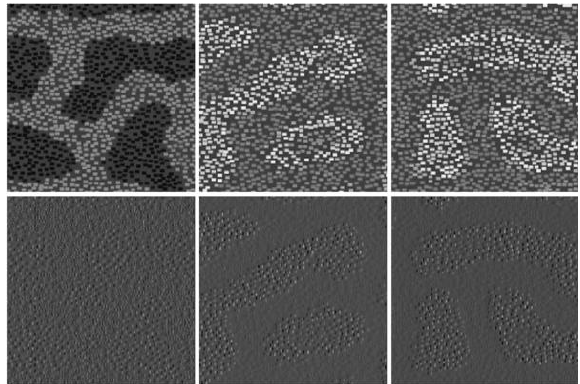
Figure 3. Textures generated with the Gray–Scott Reaction–Diffusion (RD) algorithm. First, row: height maps. Second row: relighting